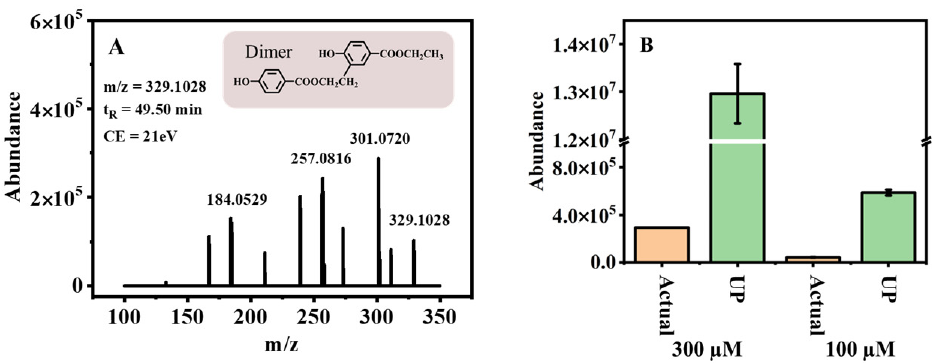
Figure 1. ( A ) MS/MS of transformation product dimer; ( B ) the formation in different concentration (300, 100 µM) under two different water quality conditions (actual—actual water, UP—ultra pure water).